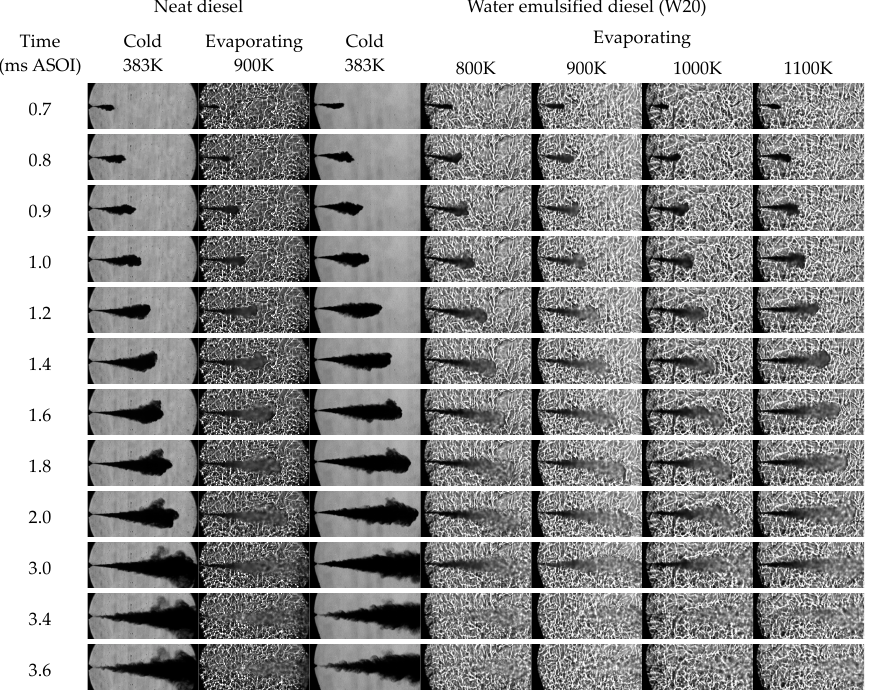
Figure 3. Spray images in cold and evaporating